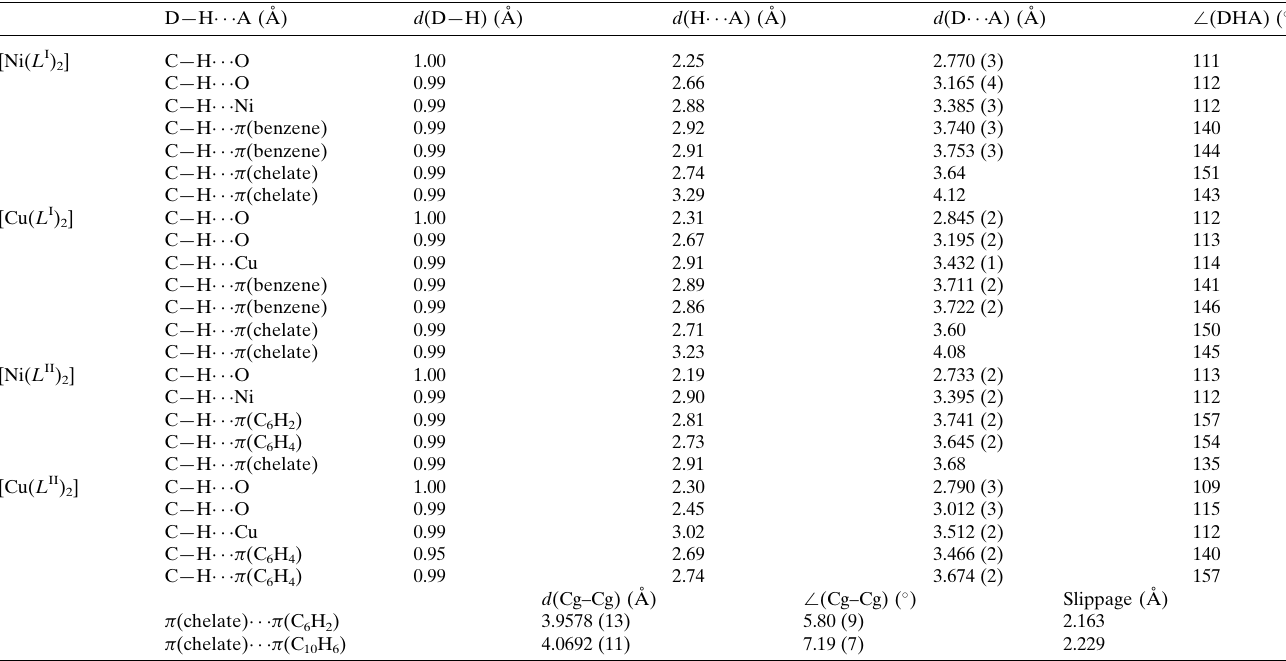
Table 2 Selected non-covalent bond lengths (A˚ ) and angles ( (cid:5) ) for [Ni( L I,II ) 2 ] and [Cu( L I,II ) 2 ]. D—H (cid:2)(cid:2)(cid:2) A (A˚ )